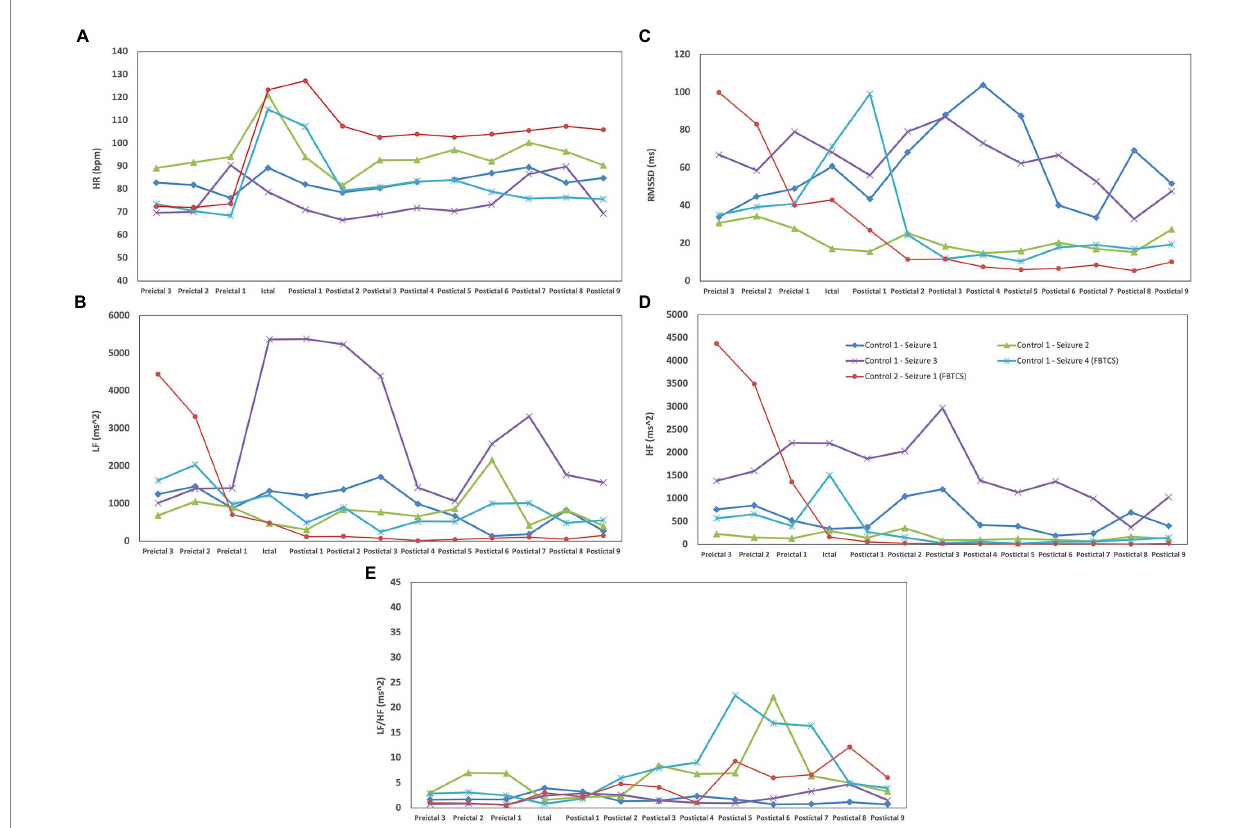
FIGURE 2 HRV changes during preictal, ictal, and postical periods in five seizures of two controls with biTLE. (A) For all seizures of both groups, we observed the same pattern of an increase in HR during the seizure and a decrease in postical HR when compared to the preictal state. (B) In 4/5 seizures of the control group, postictal LF recuperation was seen immediately after seizure termination; in 1/5 seizures of the control group (seizure 3 of control #1), LF postictal recuperation was only seen 8 min following seizure termination. (C) In controls, RMSSD generally increased during seizures, followed by an important decrease in postictal. (D) No postictal mean HF increase was noted in both controls when compared to preictal HF. (E) In seizure 2 of control #1, an important and rapid increase (218.33%) and decrease (71.07%) in LF/HF was seen between the fifth and seventh postictal periods. No similar variations were noted in the other four seizures of the